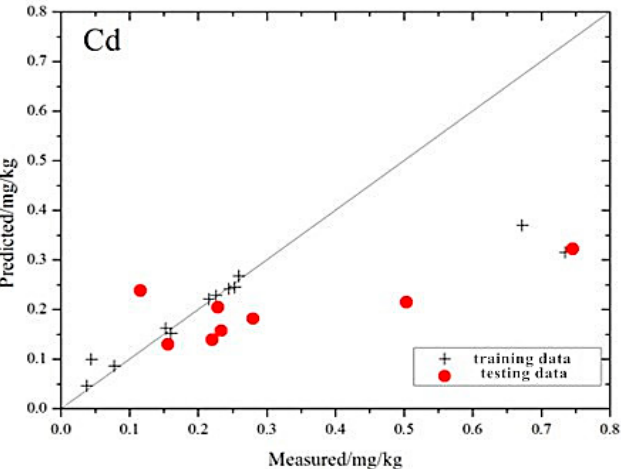
Figure 9. Individual points of the Cd concentration in the wheat planted on mine reclamation soils predicted by the SMO-SVM model against the measured values.